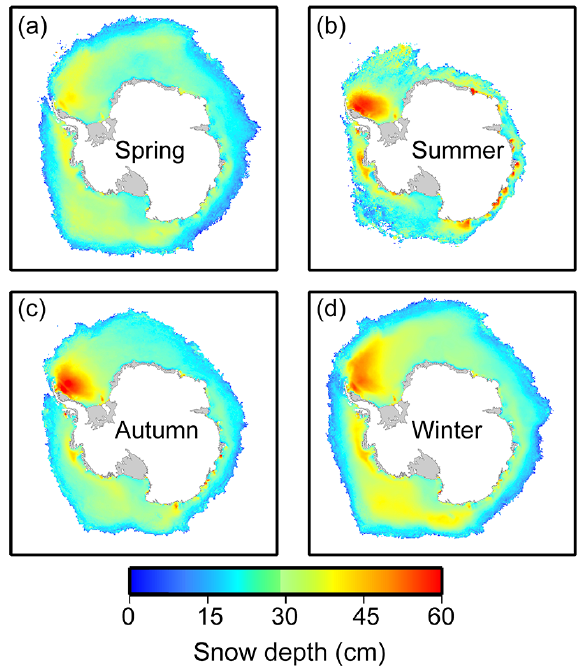
Figure 9. The spatial distributions of averaged snow depth in dif- ferent seasons from 2002 to 2020. Only grid cells with sea ice con- centration ≥ 75% are shown here; grid resolution is